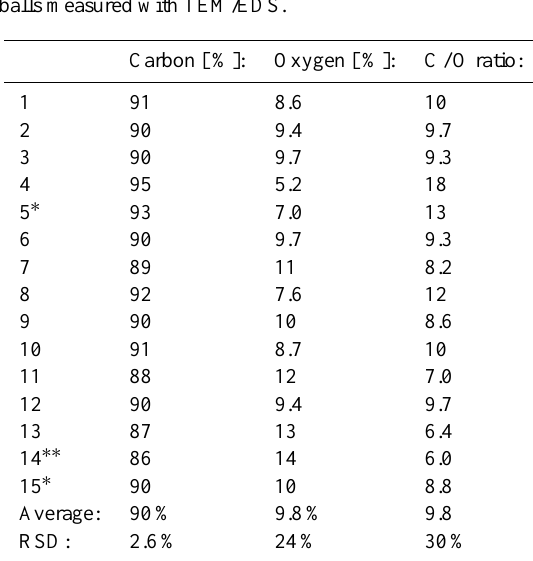
Table 1. Carbon and oxygen atomic content of laboratory-generated tar balls measured with